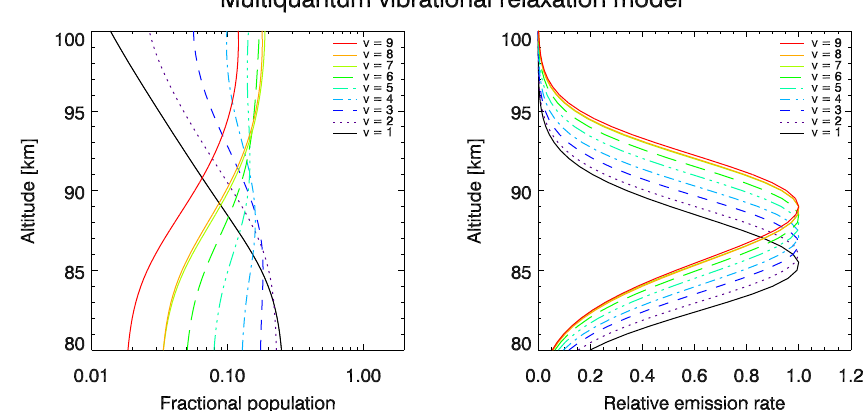
Fig. 6. Left panel: fractional populations of OH vibrational levels ν =1, ..., 9 as a function of altitude based on Eq. (4). The lifetime at level ν =9 ( A( 9 ) − 1 ) was taken from Langhoff et al. (1986), the nascent population by Steinfeld et al. (1987) (see Table 3) was used and O- quenching based on the rate constant in Adler-Golden (1997) was considered. Right panel: normalized emission rate profiles for vibrational levels ν =1, ..., 9 calculated with Eq. (7).